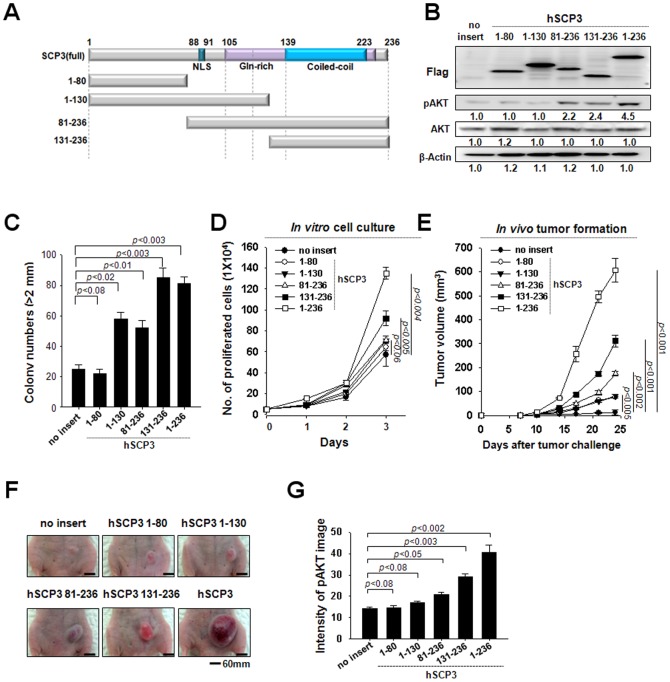
The C-terminal region of hSCP3 is important for its oncogenic capability.(A) Schematic of the domains in hSCP3. Boxes represent the NLS, Gln-rich, and coiled-coil motifs, respectively. (B) Western blot analysis of levels of hSCP3 and its deletion mutants, the N-termini of which were tagged with a Flag epitope for visualization. Numbers below western blots refer to the relative values of the intensity normalized to no insert control. (C) Soft agar colony-forming capacity of NIH3T3 expressing wild type or deletion mutants of hSCP3. (D) In vitro growth curves of NIH3T3 cells expressing wild type or deletion mutants of hSCP3. Cells were counted after trypan blue staining to exclude dead cells. (E) In vivo tumorigenicity of the NIH3T3 cells. Balb/c Nude mice (n = 5) were inoculated subcutaneously with 1×105 cells/mouse of the NIH3T3 cells expressing full length or mutant hSPC3. Error bars represent the mean ± SD. (F) Representative images of skin tumors (scale bar: 60 mm). (G) Bar graph representing intensity of pAKT fluorescence image on tumor tissue sections, ImageJ densitometry software was used to quantitate the intensity of image as described in Materials and Methods. Error bars represent the mean ± SD.